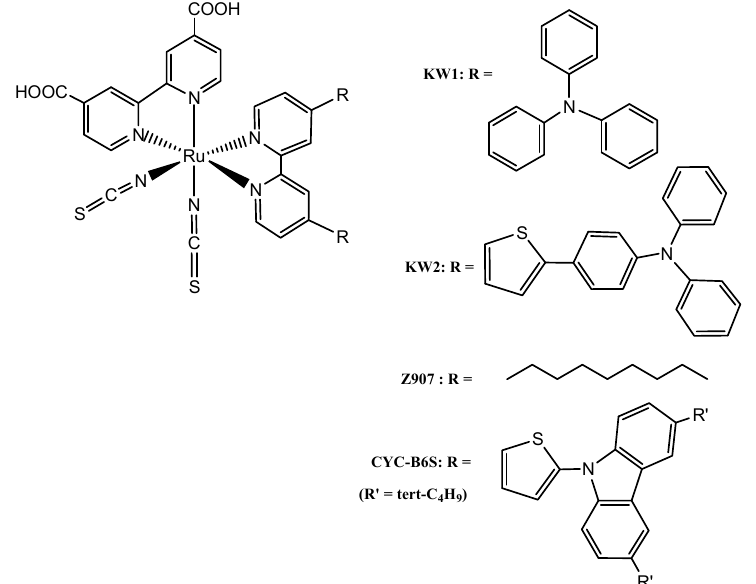
Figure 5. Molecular structures of the ruthenium complexes KW1 , KW2 , Z907 and CYC-B6S